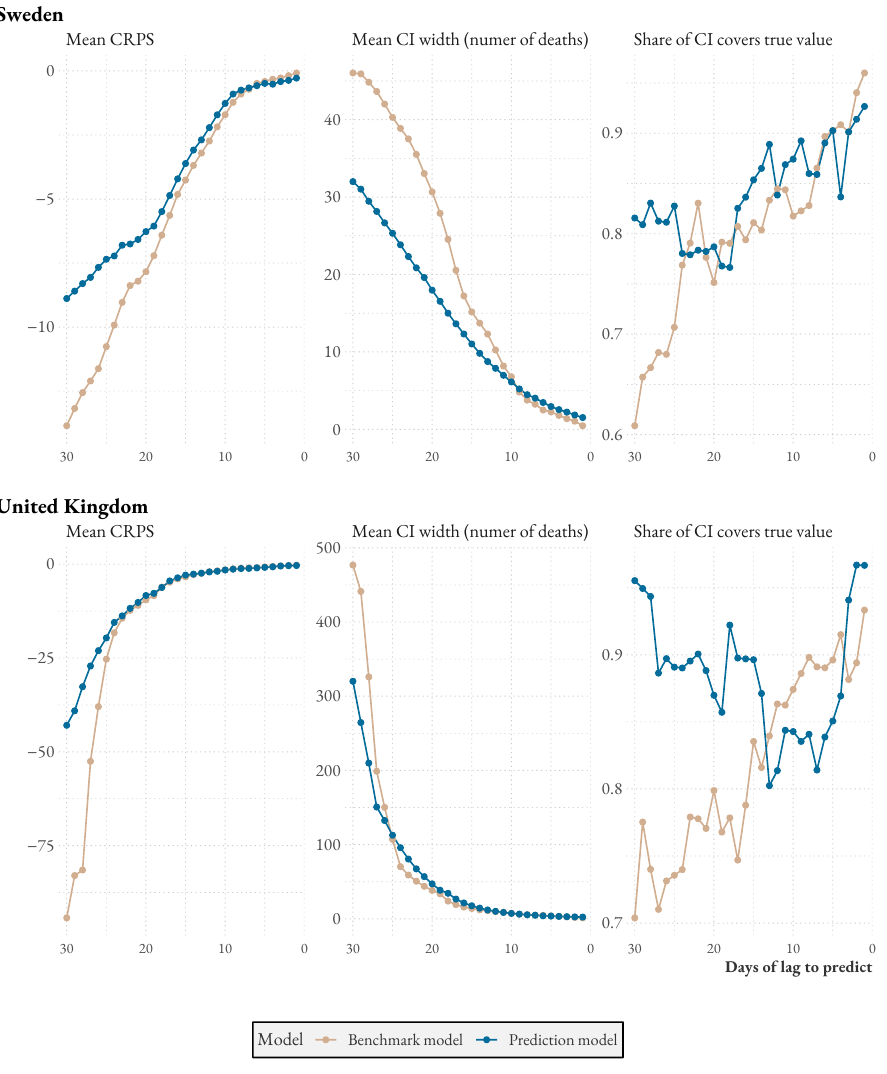
Figure 4. Average (January 2020 to May 2021) model and benchmark accuracy as more information becomes